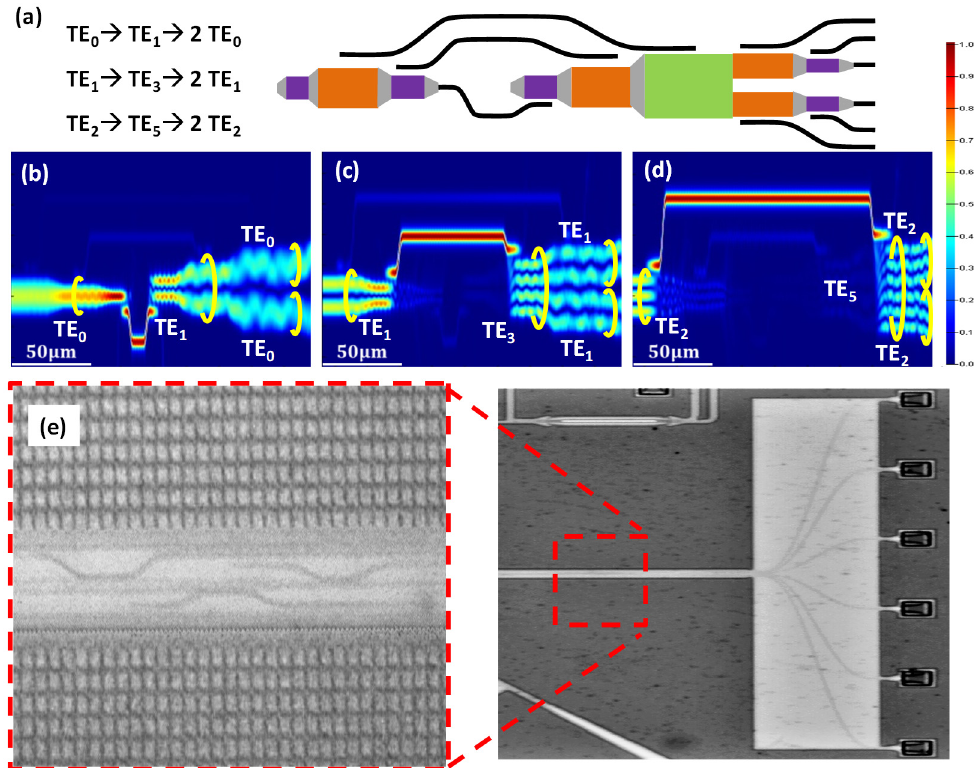
Figure 3. ( a ) Schematic of the SOI-based MDM optical power divider. FDTD simulation result of the MDM optical power divisions at ( b ) TE 0 , ( c ) TE 1 , ( d ) TE 2 . ( e ) Photograph of the MDM optical power divider, showing the magnified section of the ADCs for mode conversions.